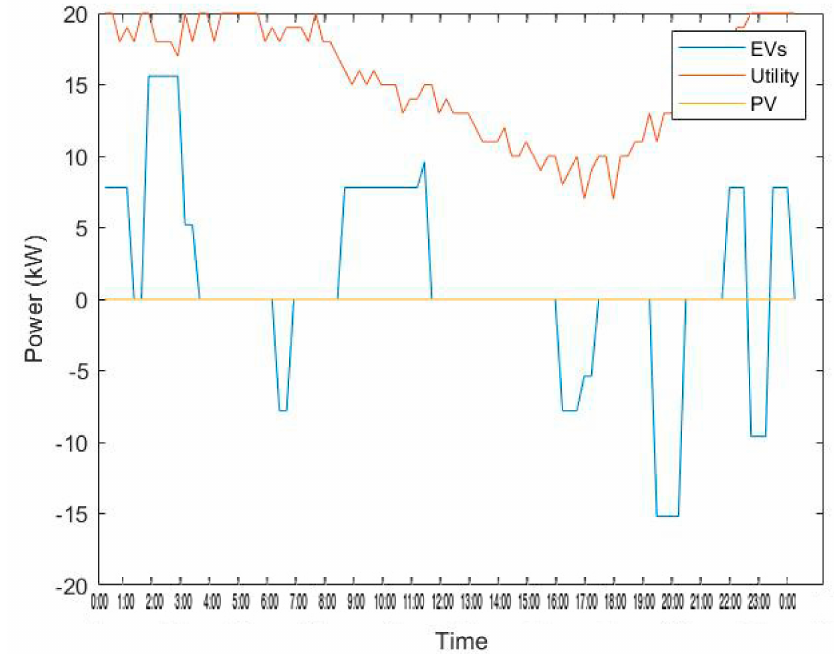
Figure 10. Utility grid power supply, EVs (V2G) and PV street generation (Cloudy